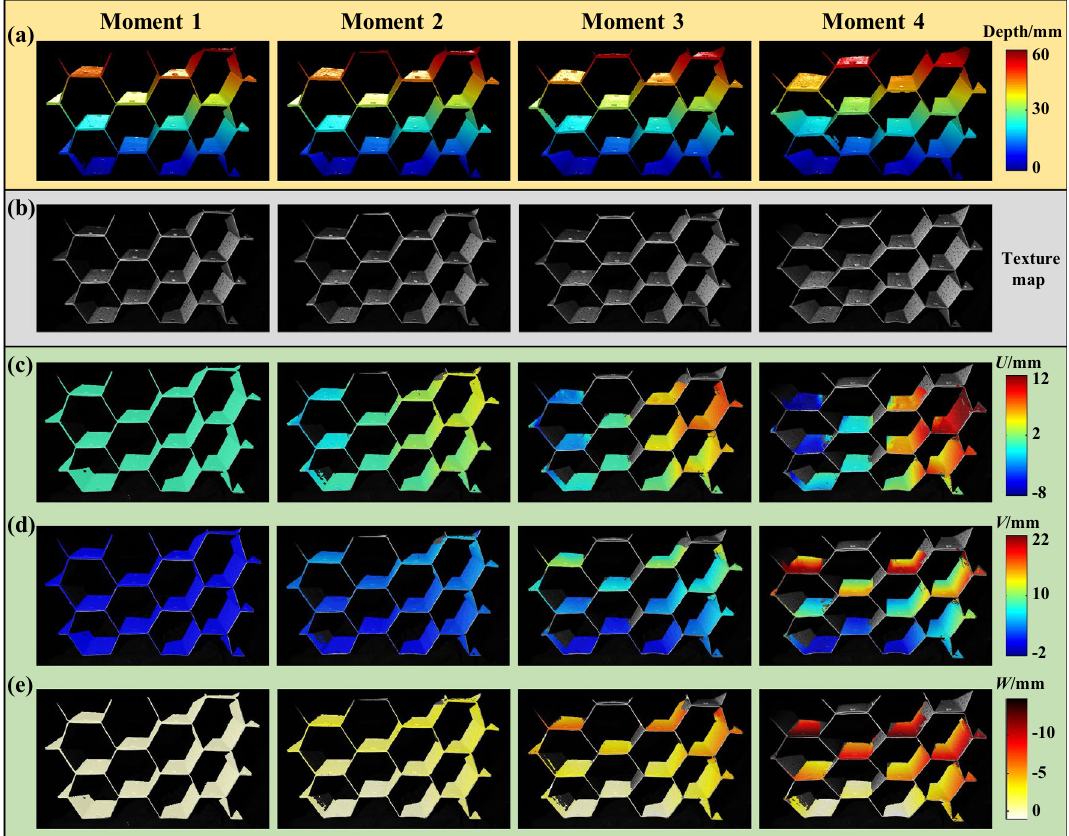
Figure 8. Measured results of the deformed honeycomb structure. ( a ) Reconstructed shapes at different moments. ( b ) Retrieved texture maps. ( c – e ) Restored U , V , W deformation at corresponding moments compared with that of moment